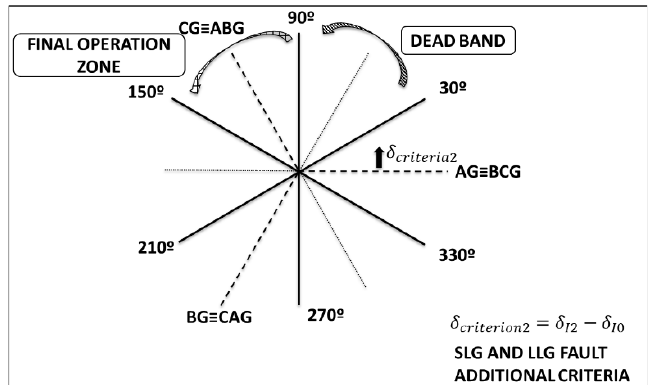
Figure 12. Criterion 2 for single line to ground and line to line to ground faults Operation principle based on sequence networks [17].